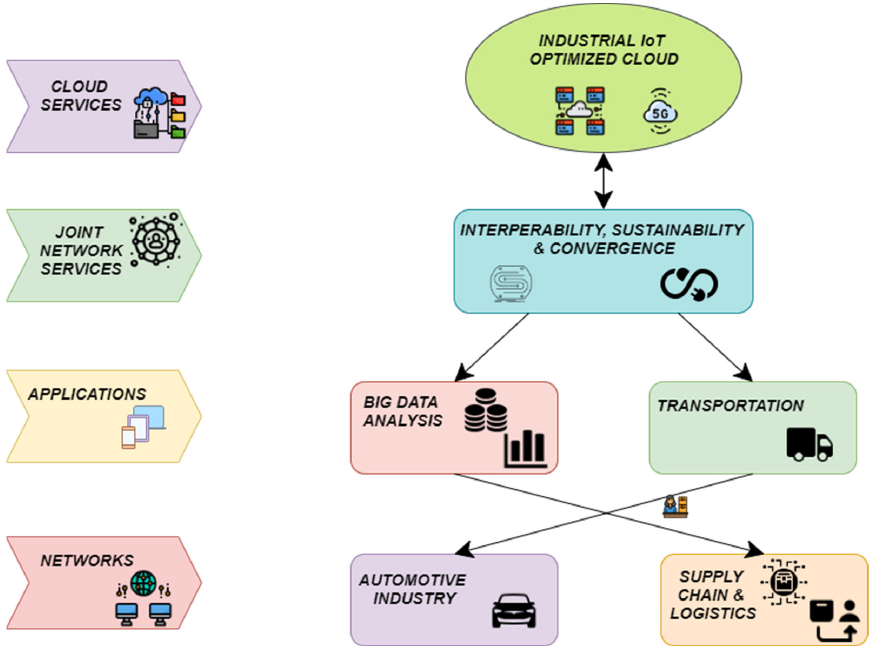
Figure 5. Compliant traffic on the highway using embedded sensors to interact with vehicles.